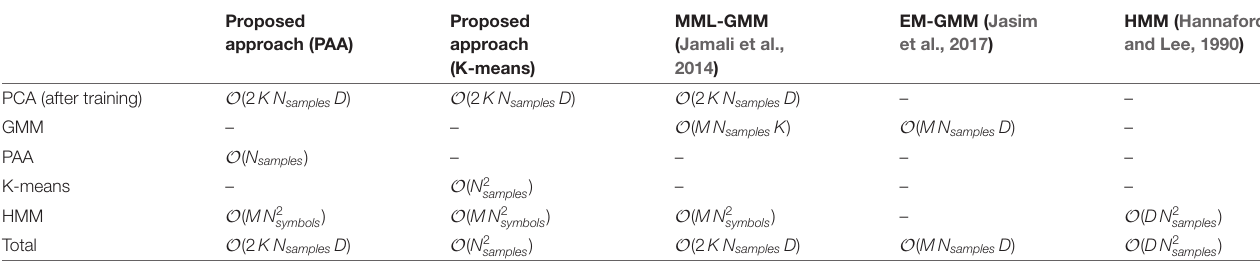
TABLE 7 | Computational complexity